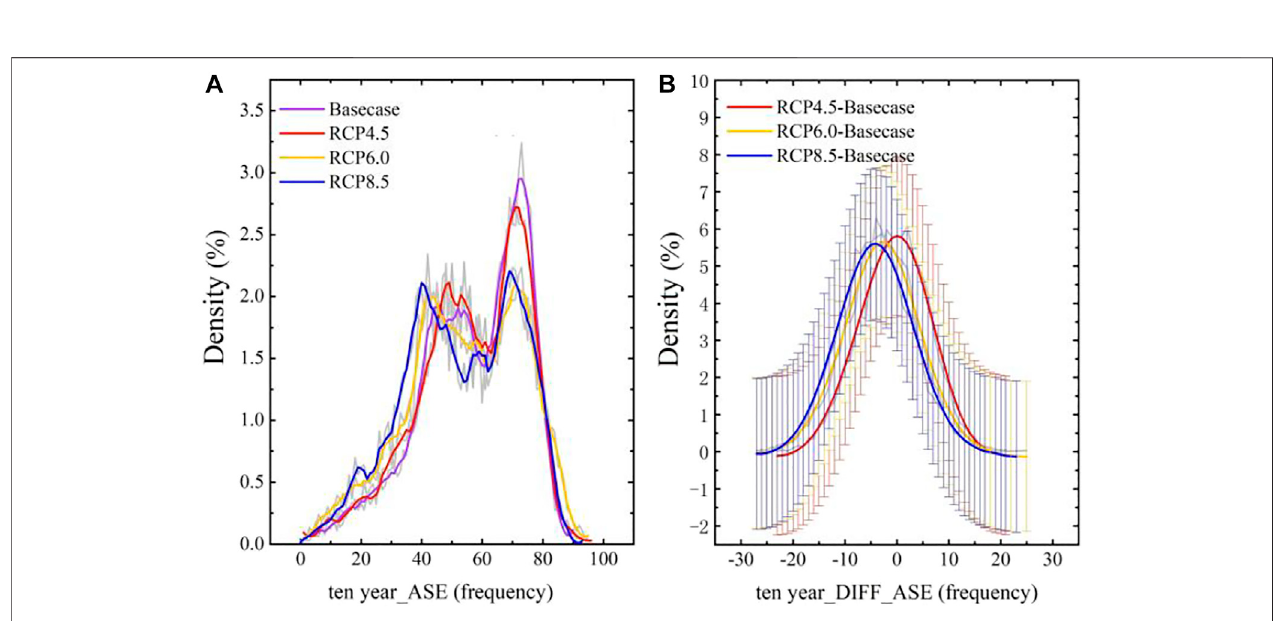
FIGURE 5 | Spatial distribution of atmospheric stagnation days, (ASD) and air stagnation events (ASE) in Basecase and their changes under the three RCPs over China. Signi fi cant changes (con fi dence level of 95%) are marked with circles.